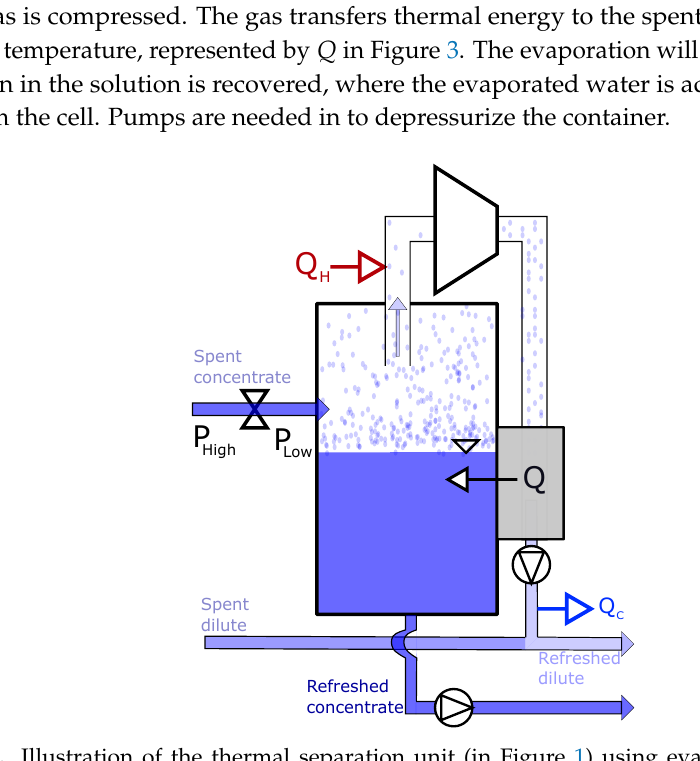
Figure 3. Illustration of the thermal separation unit (in Figure 1) using evaporation. The spent concentrated solution from RED, is decompressed to a lower evaporation temperature, before heat (Q) is added and water evaporated from the spent dilute solution. The vaporised water is heated (Q H ) and compressed, before thermal energy is exchanged with the spent concentrated, and the vaporised water is condensed back to a liquid and added to the spent dilute